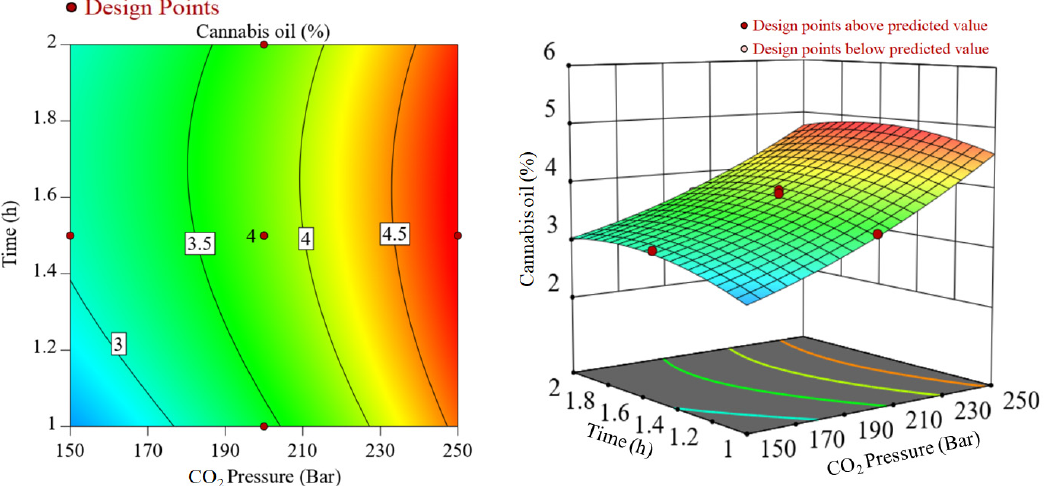
Figure 3. Interactions between CO 2 pressure and time during SCCO 2 extraction at a constant temperature of 40 ◦